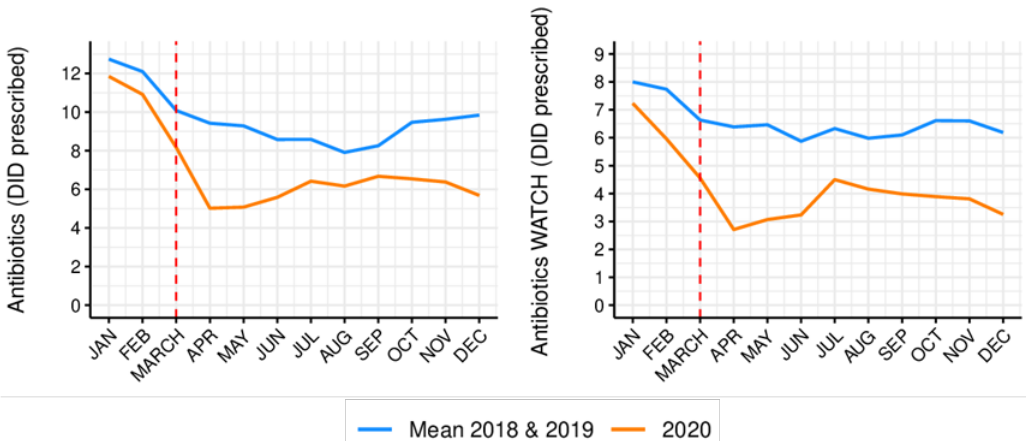
Figure 1. Changes in monthly antibiotic prescribing as DID in outpatient care, before and after COVID-19 emergence.